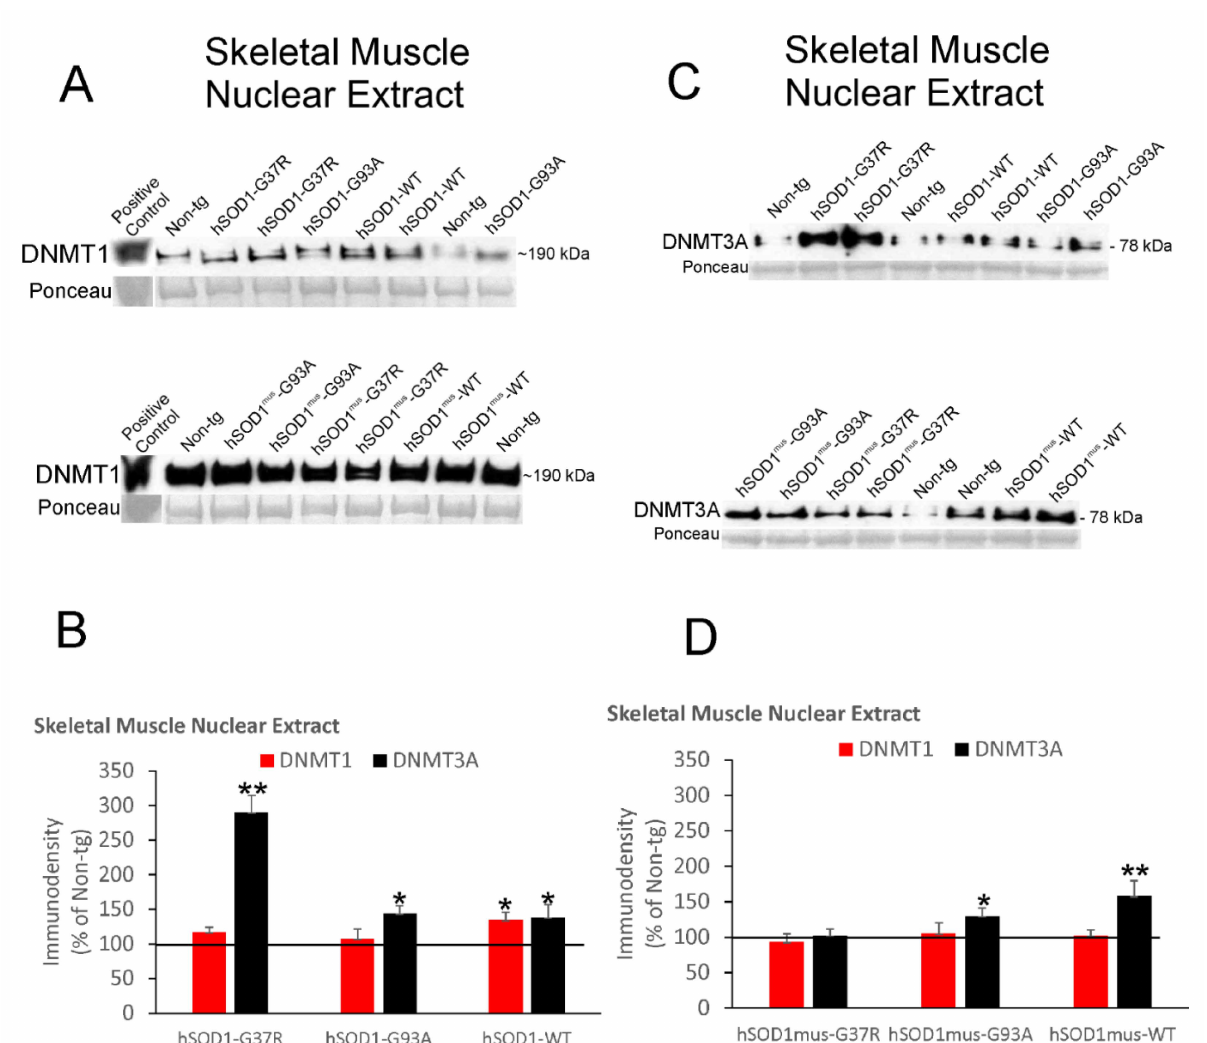
Figure 4. Western blot analysis of DNMT1 and DNMT3A protein levels in nuclear extracts of skeletal muscle from nonconditional hSOD1 tg mice and hSOD1 mus mice. Representative immunoblots for DNMT1 ( A ) and DNMT3A ( C ) are shown. The different tg mouse lines were randomized to lane assignments. Sizes of DNMT1 and DNMT3A (in kDa) are indicated for each blot at right. Each blot had a positive control lane. Ponceau S-stained membranes show protein loading. ( B ) Protein IR levels (mean ± SD, as % of non-tg mouse immunodensity) for DNMT1 and DNMT3A in non- conditional hSOD1 mouse lines ( n = 5/genotype). * p < 0.05; ** p < 0.001. ( D ) IR protein levels (mean ± SD, as % of non-tg mouse immunodensity) for DNMT1 and DNMT3A in hSOD1 mus mouse lines ( n = 5/genotype). * p < 0.05; ** p <